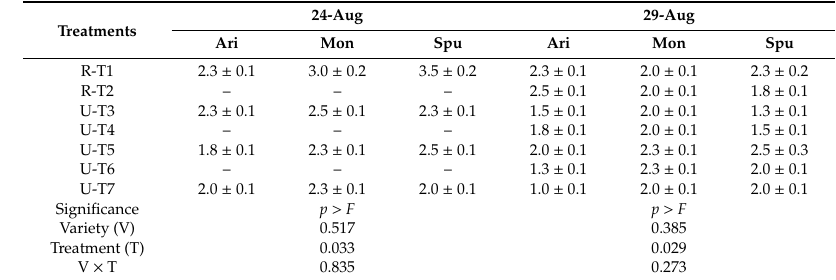
Table 10. Average ( ± standard error) ABA content (ng g − 1 fresh weight) in seed-tubers subjected to sevent dormancy-breaking treatments. Abscisic acid analysis was done before and after the application of gibberellic acid (Experiment 2).